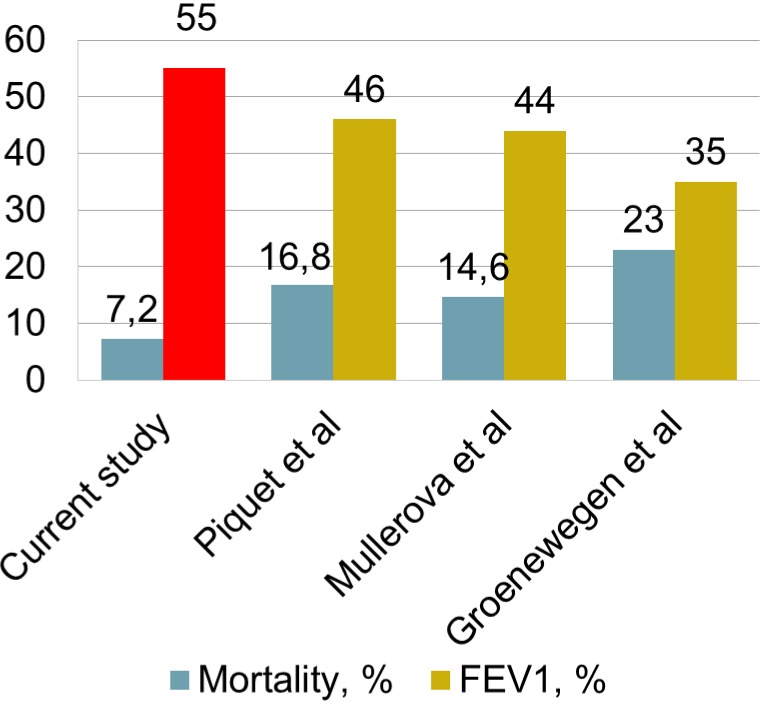
Association between mortality and FEV1.FEV1 (%) in the current study shown in red.